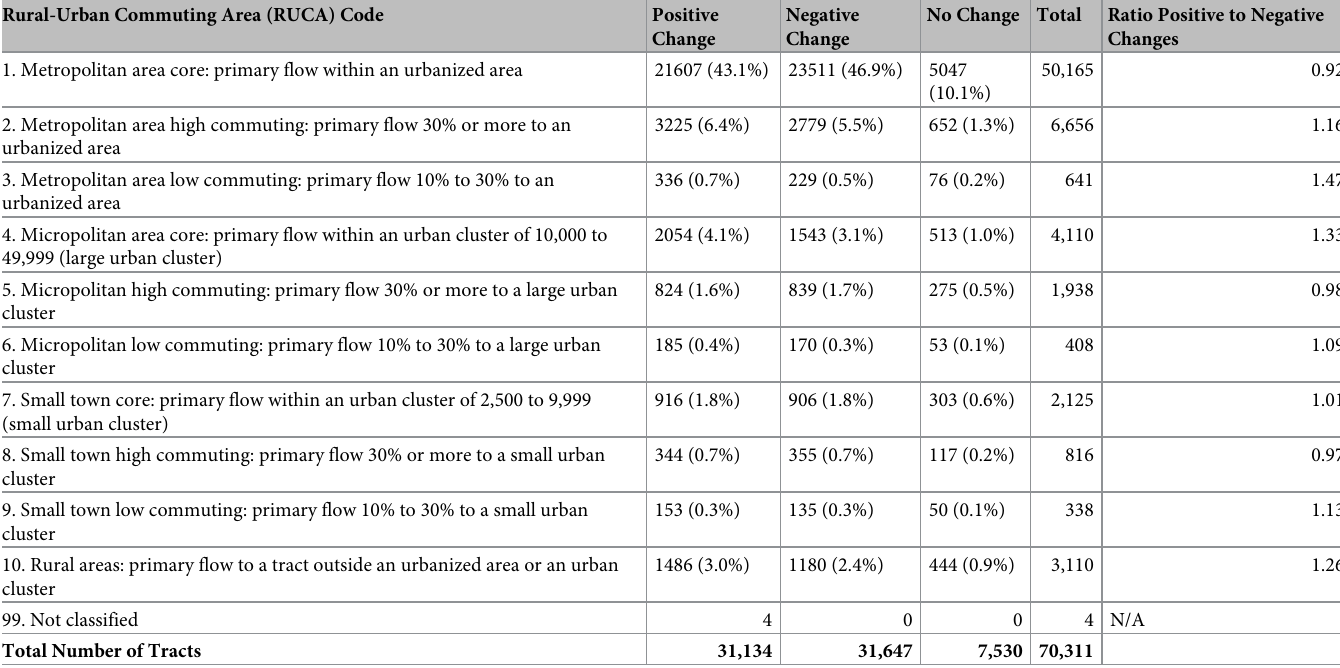
Table 8. Distribution of provider change across the urban-rural hierarchy. Rural-Urban Commuting Area (RUCA)